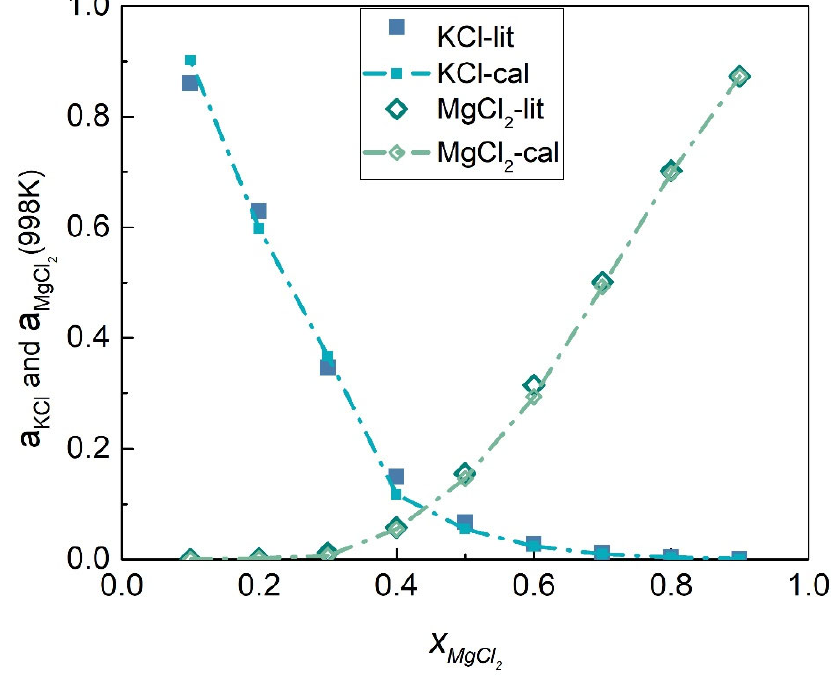
Figure 16. Comparison of calculated activities and literature data of each element of the KCl-MgCl 2 system (998 K).